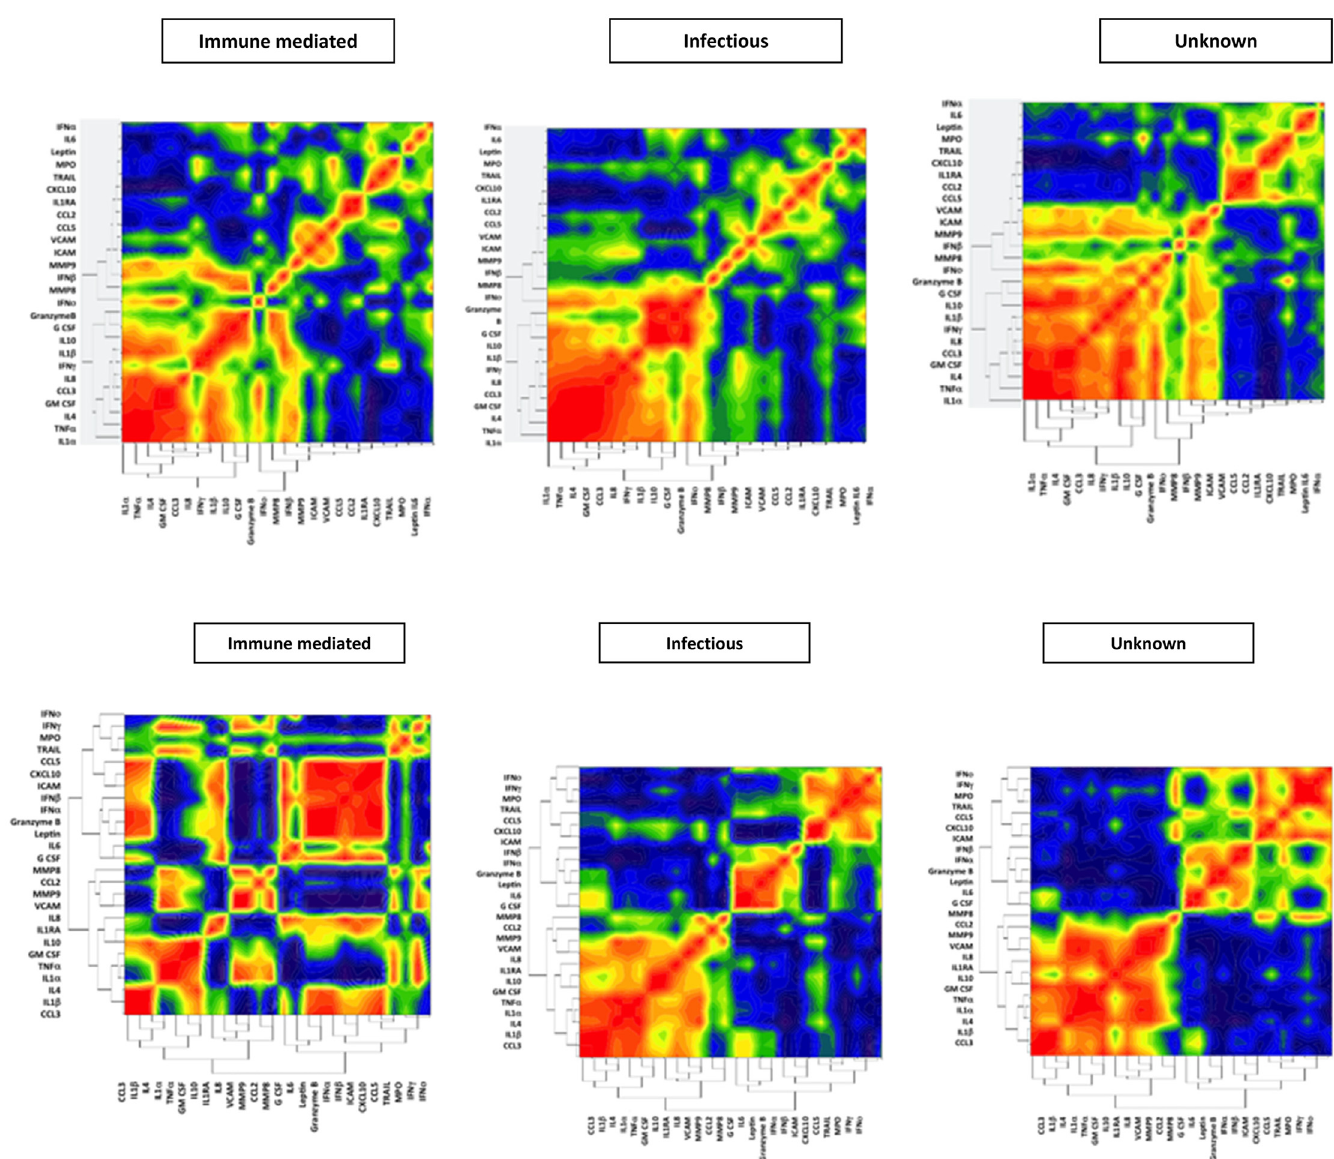
Fig 4. The heatmaps give a visual representation of how closely concentrations of different mediators correlate in the samples by nearest neighbour correlation. Using a hierarchical cluster analysis the mediators are listed in the same order for each of the three aetiological groups to allow a visual comparison of the pattern between the groups. In the serum (a) the pattern of mediator correlations is similar for all three aetiological groups, where-as in the cerebrospinal fluid (b) the pattern differed between immune-mediated and infectious aetiologies, and the pattern for those of unknown aetiology is closer to that seen with